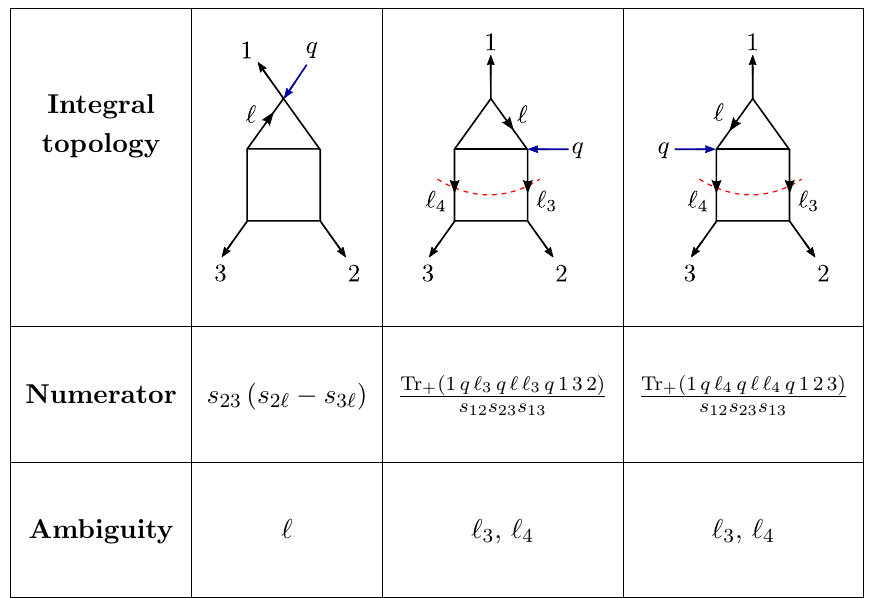
Table 1 . Summary of the results of the two-particle cuts so far. All numerators have the tree-level form factor factored out. The propagators which appear cut are still ambiguous given the cuts performed so